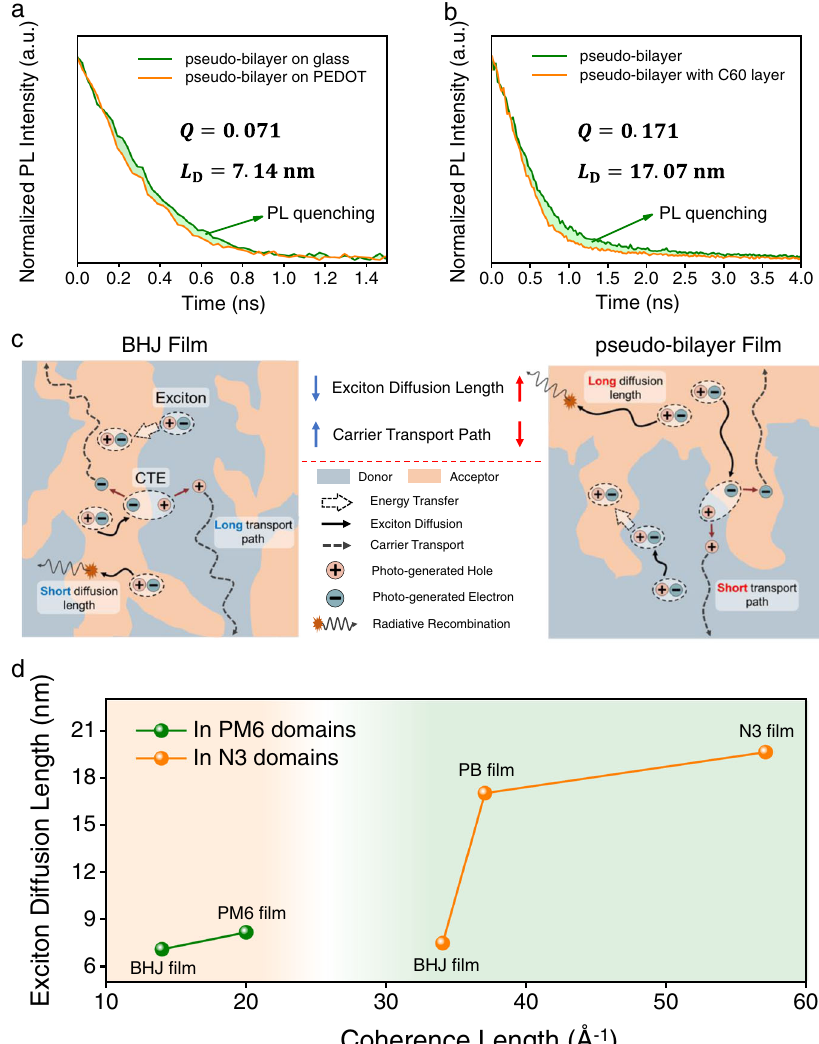
Fig. 4 Performance analysis of OSCs. a , b PL quenching for the PB fi lm prepared on a PEDOT layer and coated with b C 60 layer, respectively. c Schematic of the behaviors of exciton and charge carriers in the BHJ and PB fi lm. d Exciton diffusion length plotted as a function of CL in the